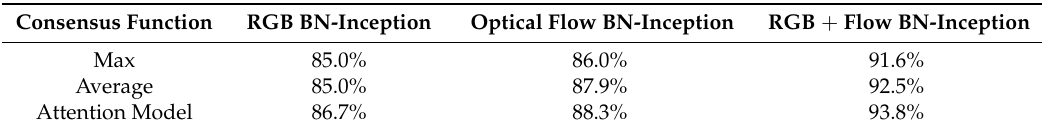
Table 2. Classification accuracies by exploring different segmental consensus functions on the UCF-101 dataset (split1).